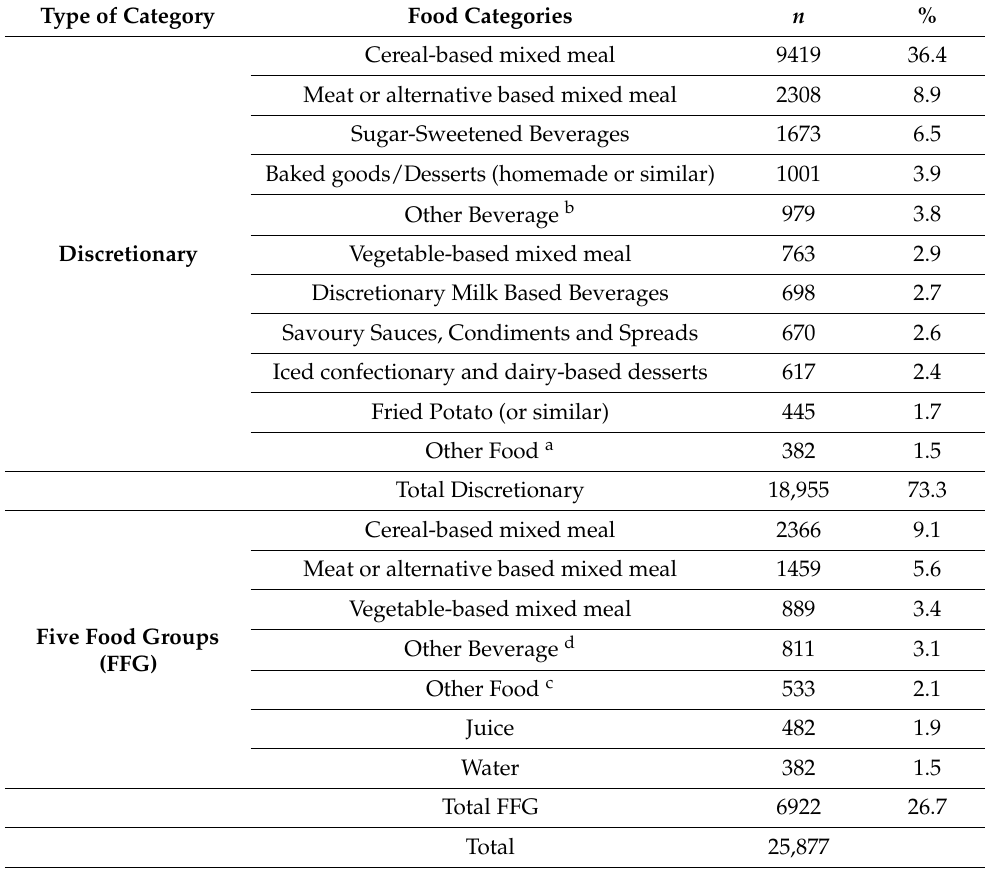
Table 2. The proportion of food and beverage categories in complete menus ( N = 25,877) from 354 local independent and franchise restaurants and takeaway outlets in descending order. Excludes combination menu item menu